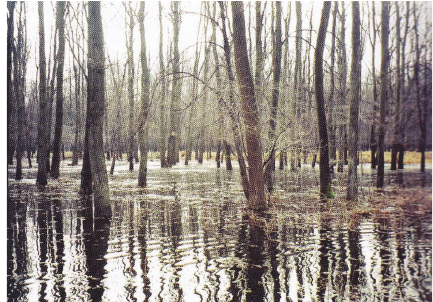
Figure 6: Large-scale artificial inundation.